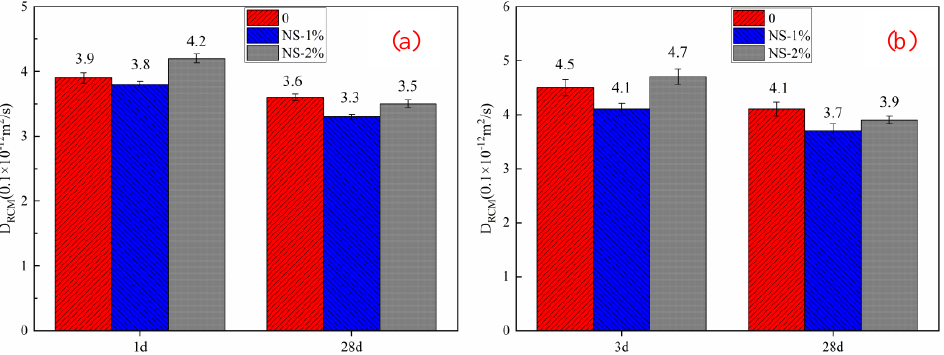
Figure 13. Chloride penetration resistance of cement mortar: ( a ) HBSAC cement; ( b ) P·O 42.5 ce- ment.